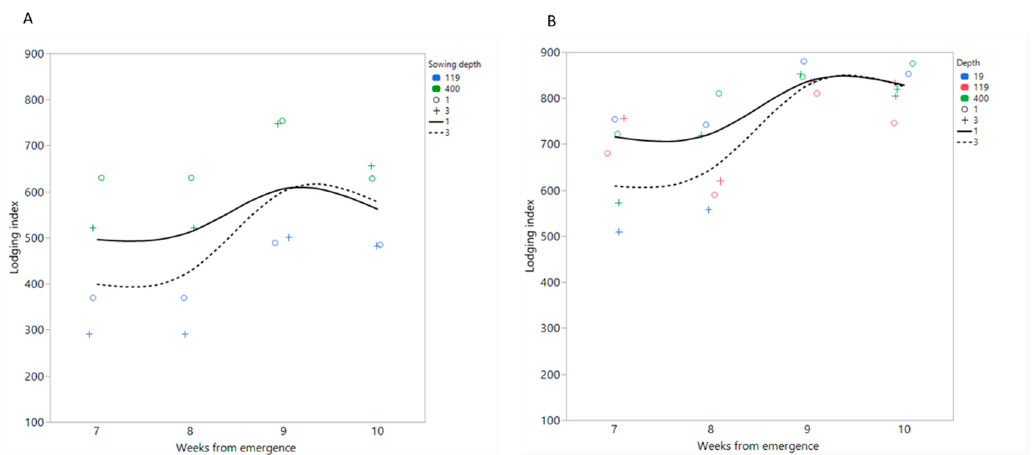
Figure 6. Field experiment. Effects of sowing depth (+, dashed line: 3 cm; o, full line: 1 cm) on seasonal trends of lodging index of three tef genotypes (RTC119–red, RTC 400—green, and RTC-19—blue) in ( A ) 2019 and ( B ) 2020.